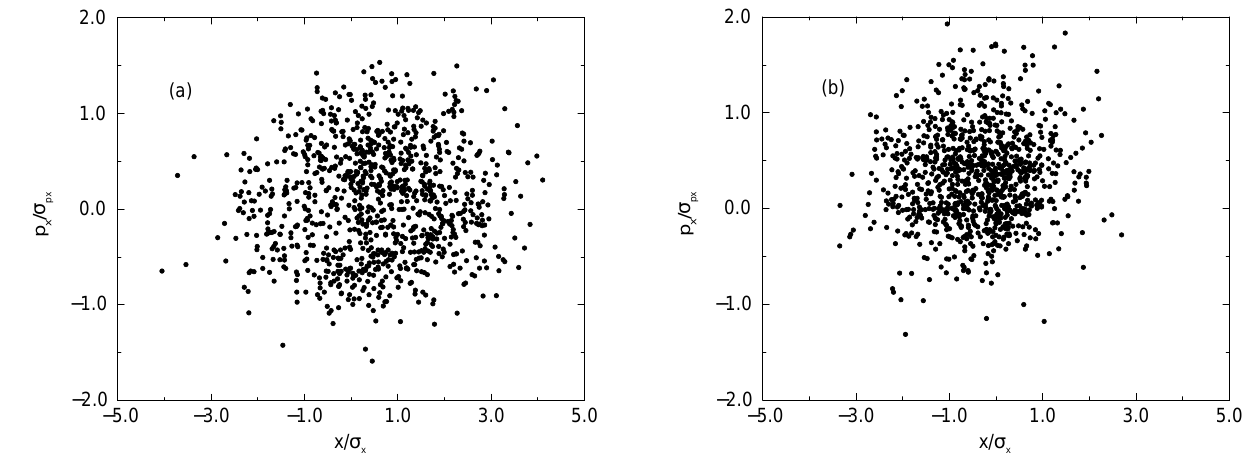
FIG. 6. Traverse phase space: normalized p x versus normalized x , for c s (cid:1) 0.15 rad. The final average beam energy is at 3 TeV (see text). (a) Without magnets and (b) with magnets.